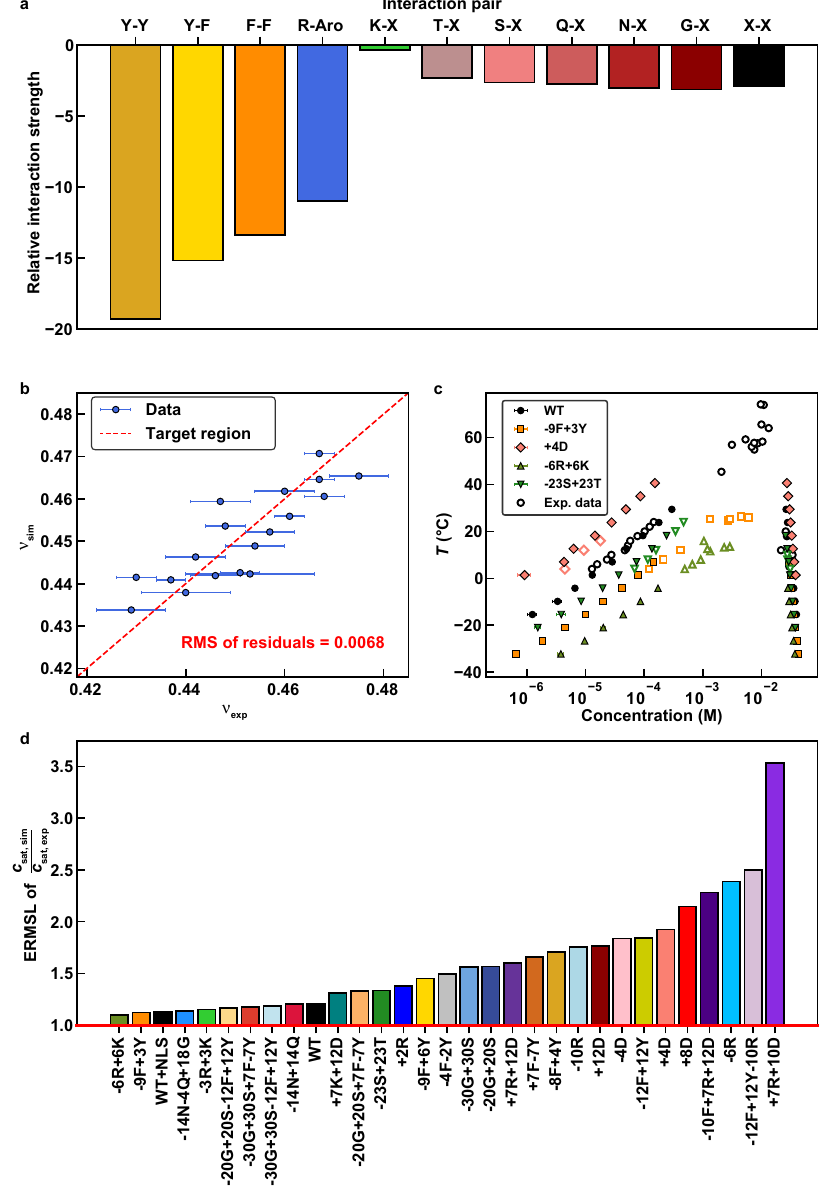
Fig.1|Setupandassessmentofthecomputationalmodel.a Pairwiseinteraction parameterize a computational model.Eachdata point correspondsto a unique A1- strengths used in the computational model. Amino acids are referred to by single- LCD variant. The red dashed line represents the regime where ν exp = ν sim , and the root mean squared error is calculated using the residuals from this line. Vertical lettercodes. “ X ” isusedtoindicateanyaminoacidforwhichaspeci fi cinteractionis errorbarsrepresentingthestandarderroraboutthemeanacross fi vereplicatesare not de fi ned. “ Aro ” is used to indicate either tyrosine or phenylalanine. Contact smaller than the markers. Horizontal error bars represent the uncertainty from energies for Y-Y, Y-F, F-F, R-Aro, K-X, and X-X were parameterized using Gaussian fi ttingtheSAXS datato molecularformfactors. c Calculatedcoexistencecurves or process Bayesian optimization (GPBO; see supplemental material and Supple- binodals (solid markers) of various A1-LCD variants plotted alongside experimen- mentary Fig. 1). All other energies were parameterized by matching experimental tally derived binodals (open markers). Temperature and concentration are con- and computational phase diagrams of “ spacer ” variants 13 (see Supplementary Methods). b R g valuesscalewithchainlengthaccordingtotherelation R g ~ N ν .Here, verted from simulation units to Kelvin and molar units, respectively, using the fi c, and is ν is actually an apparent scaling exponent ν scalingfactorsofMartinetal. 9 .Errorbarsrepresentstandarderrorsfromthemean app , that is sequence speci extracted from SEC-SAXSdatausingtheapproachdeveloped byRibacketal. 79 .We across 3 replicates. d ERMSL (see Supplementary Methods) comparing experi- compare values of ν obtained by fi tting SEC-SAXS data to a molecular form factor mentally measured ( c sat,exp ) and computationally derived ( c sat,sim ) saturation con- centrations. Source data are provided as a Source Data fi ( ν exp )tothoseobtainedfromsingle-chainLaSSIsimulations( ν sim )anduseGPBOto